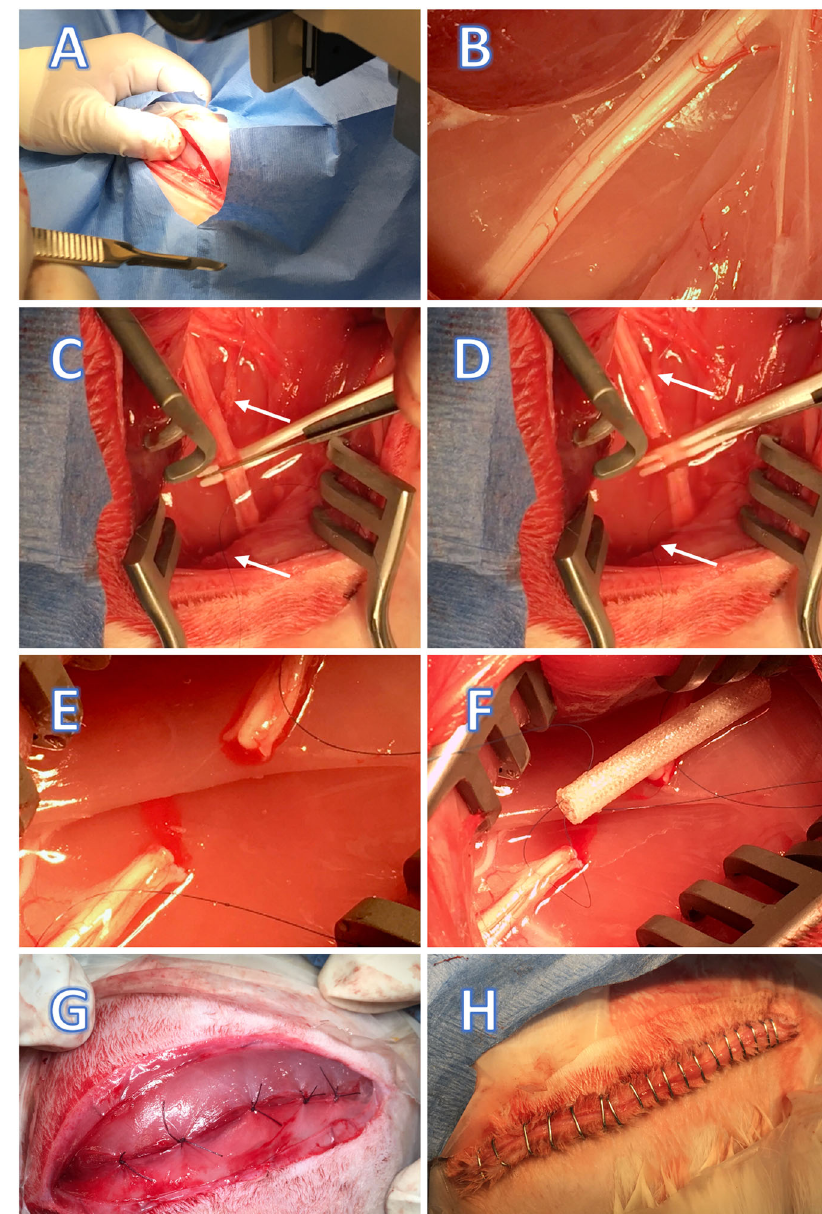
Fig. 1 A palpatory identi fi cation of the reference points; ( B ) visual identi fi cation of the sciatic nerve; ( C – E ) after a proximal and a distal trans- epineural anchoring was made by a double-arm 7-0 nylon mono fi lament (arrows), a sharp cut was produced with the assistance of a 3D printed tool; ( F ) a polymeric arti fi cial nerve- guide was implanted; ( G ) a resorbable 5-0 suture was used for the fascia; ( H ) a skin closure with metallic staples completed the